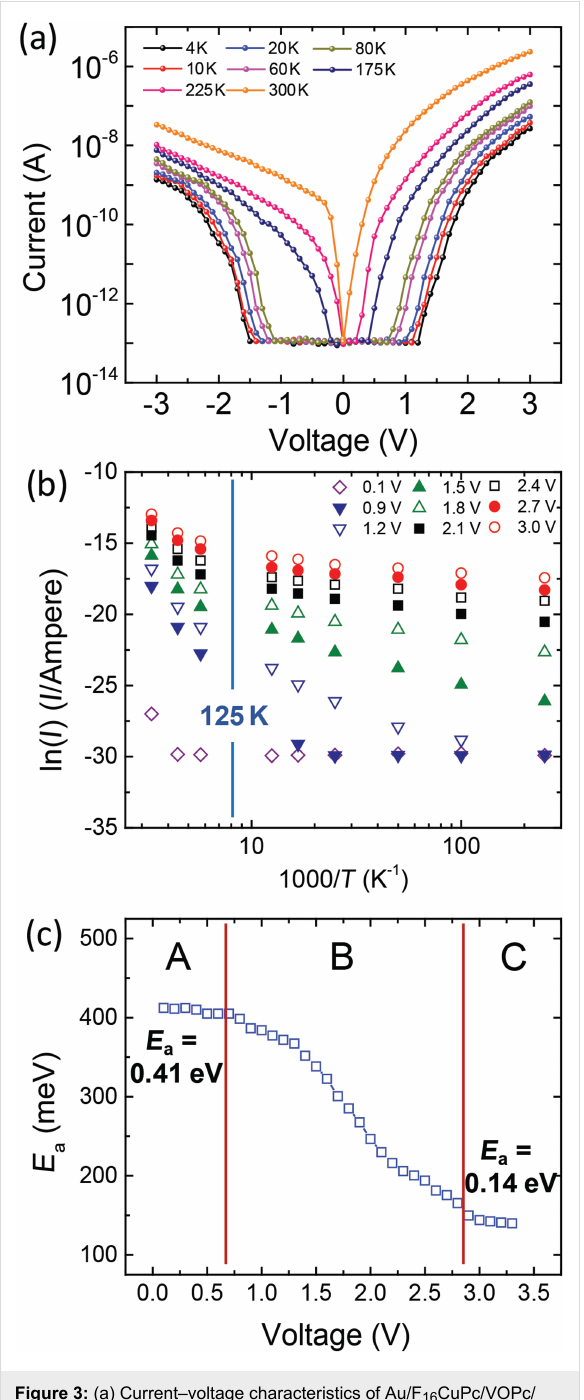
Figure 3: (a) Current–voltage characteristics of Au/F 16 CuPc/VOPc/ F 16 CuPc/Au diode as a function of temperature. (b) Current–tempera- ture characteristics at different voltages. (c) Applied voltage depen- dence of thermal activation energy.